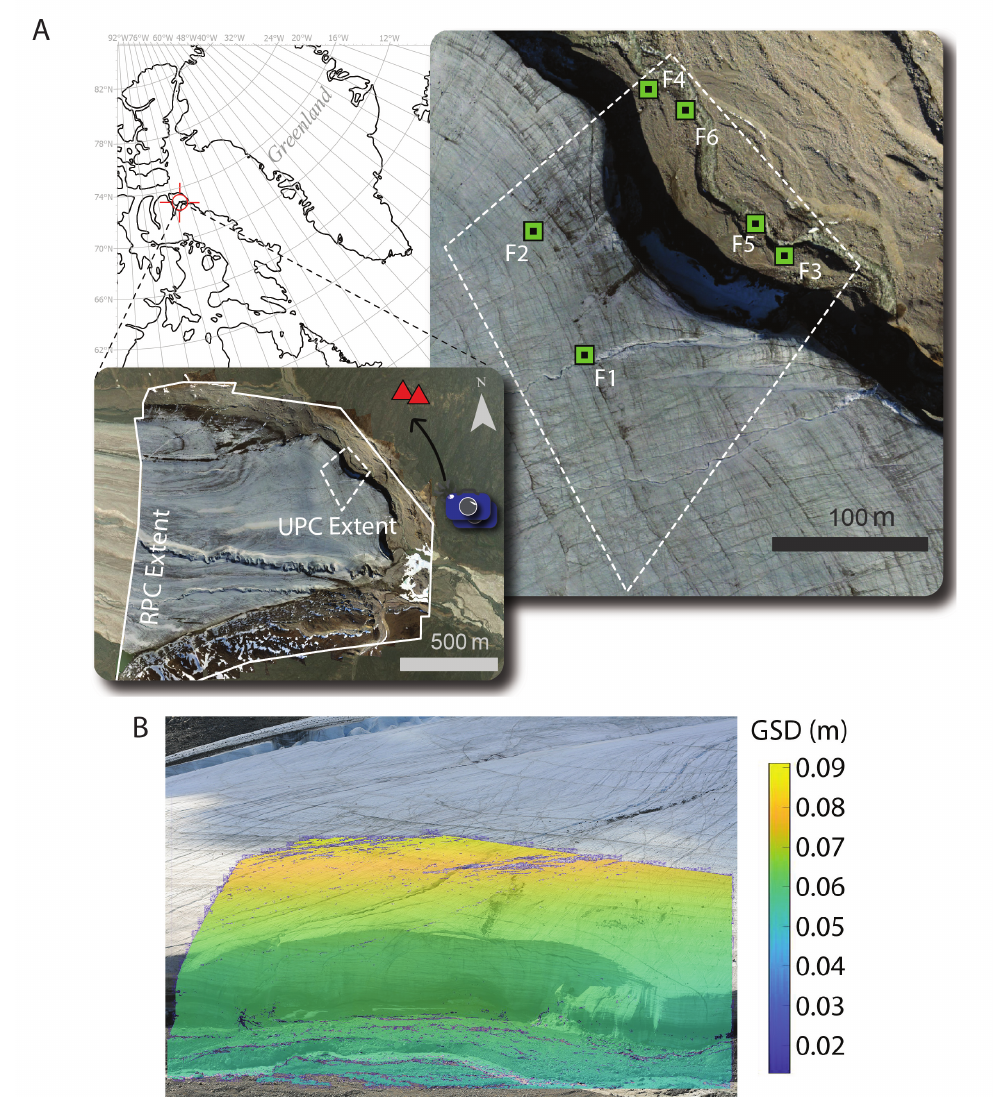
Figure 5. ( A ) Fountain Glacier, Nunavut, Canada, was surveyed in July 2010. Two cameras were left in place collecting daily stereo image pairs (red triangles). The extent of the RPC (RPC; solid outline) is shown in relation to the unreferenced point cloud (UPC; dashed outline). Surveyed control points are shown in green. ( B ) This example image from one of the cameras shows the view of the camera with the ground sampling distance (GSD)